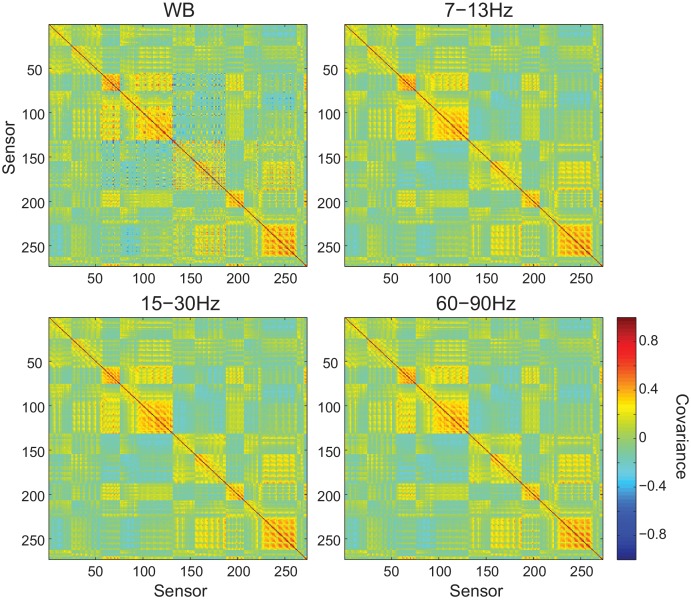
Sensor covariance is similar across frequency bands.Each panel shows the sensor covariance computed from empty room recordings for wide band (WB) and filtered data within each frequency band analyzed. While the covariance matrices are not perfectly diagonal, they are similar across frequency bands.